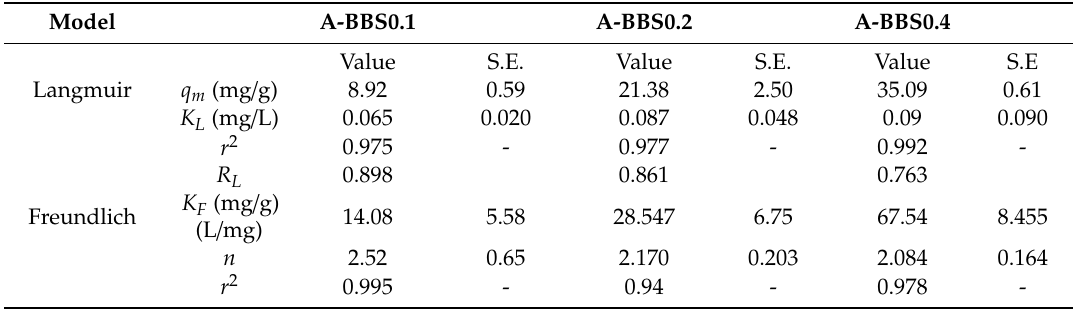
Table 4. Langmuir and Freundlich model parameters calculated by linear fitting of the adsorption data. Model